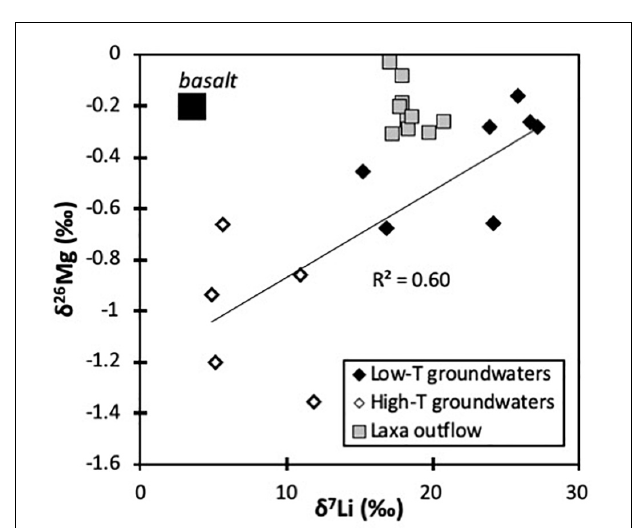
FIGURE 6 | Mg isotope ratios as a function of Li isotope ratios (Pogge von Strandmann et al., 2016). Fractionation-controlling mechanisms are clearly different in these two systems (see text for